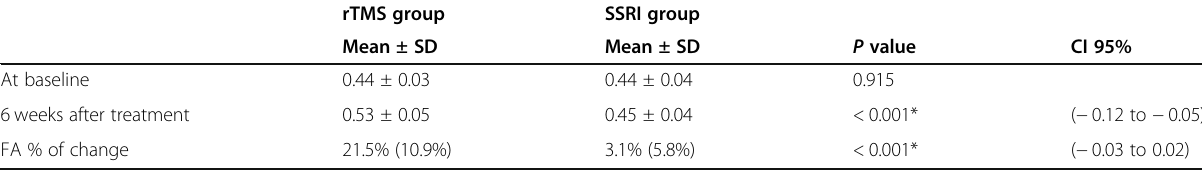
Table 3 Comparison between FA value before and after treatment